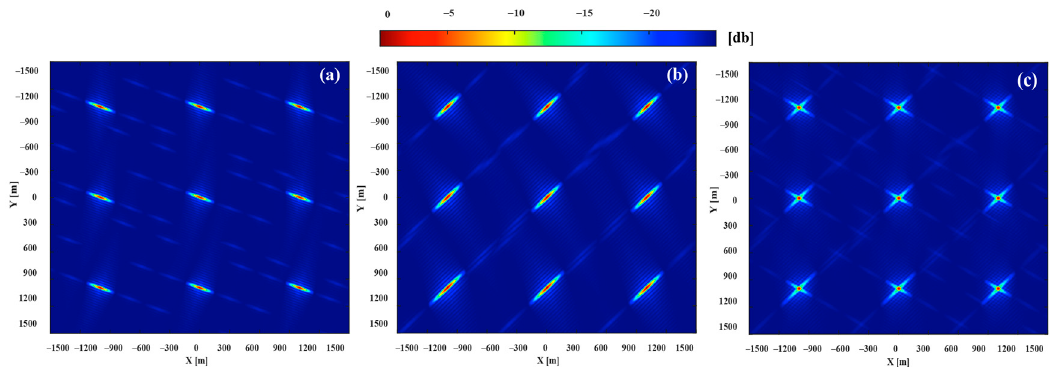
Figure 12. The imaging results: ( a ) is the imaging results of PRN21, ( b ) is the imaging results of PRN10, and ( c ) is fusion imaging results of PRN21 and PRN10.